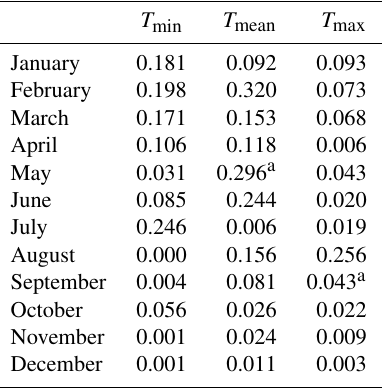
Table 9. Relationship ( R 2 ) of minimum snow cover fraction (%) and monthly T min , T mean and T max from 2002 to 2013.